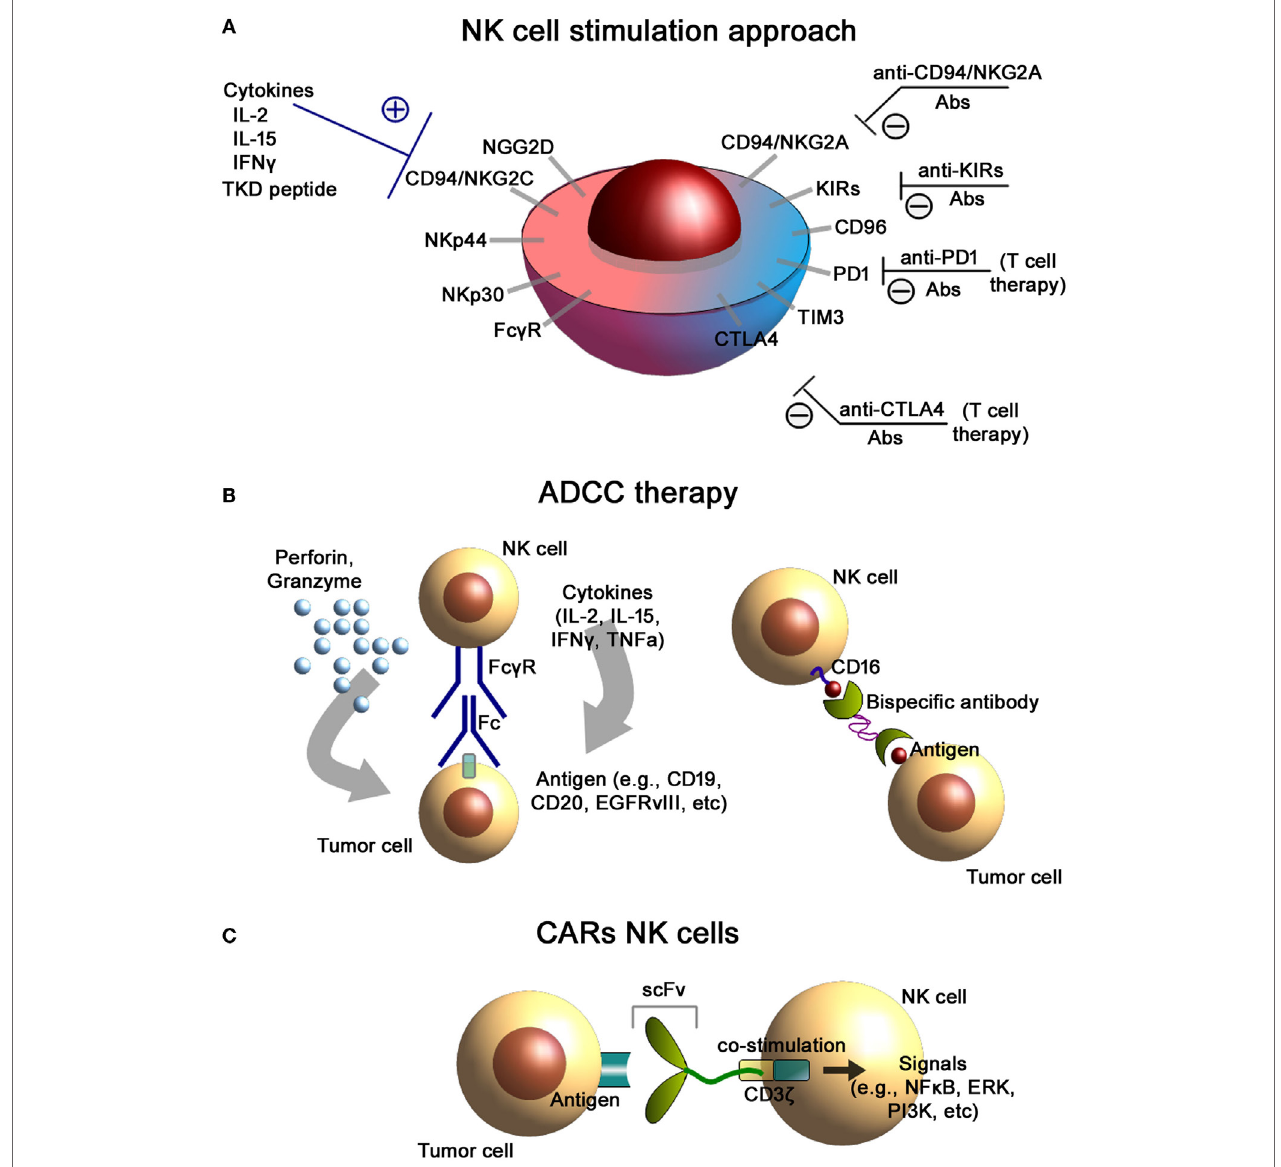
FiGURe 1 | NK cells-based immunotherapeutic concepts . (A) NK cell stimulation approach. Antibody-mediated blockade of the inhibitory receptors expressed on the cell membrane of NK cells as well as stimulation of the activating receptors results in an increased cytolytic activity of NK cells. (B) Antibody-dependent cellular cytotoxicity (ADCC) therapies. Binding of the Fc γ R to the Fc fragment of the antibody ( left ) results in the activation of NK cells and induces the release of effector molecules such as perforin and granzyme. Application of bispecific antibodies ( right ) directed against CD16 (on NK cells) and tumor antigens facilitate conjugate formation of NK cells with tumor cells. (C) Chimeric antigen receptor (CAR)-engineered NK cells. CAR consists of an external recognition domain [i.e., small chain variable fragment (scFv)] that recognizes the tumor-specific antigen, a transmembrane domain, and an intracellular signaling domain (CD3- ζ chain) that induces NK cell